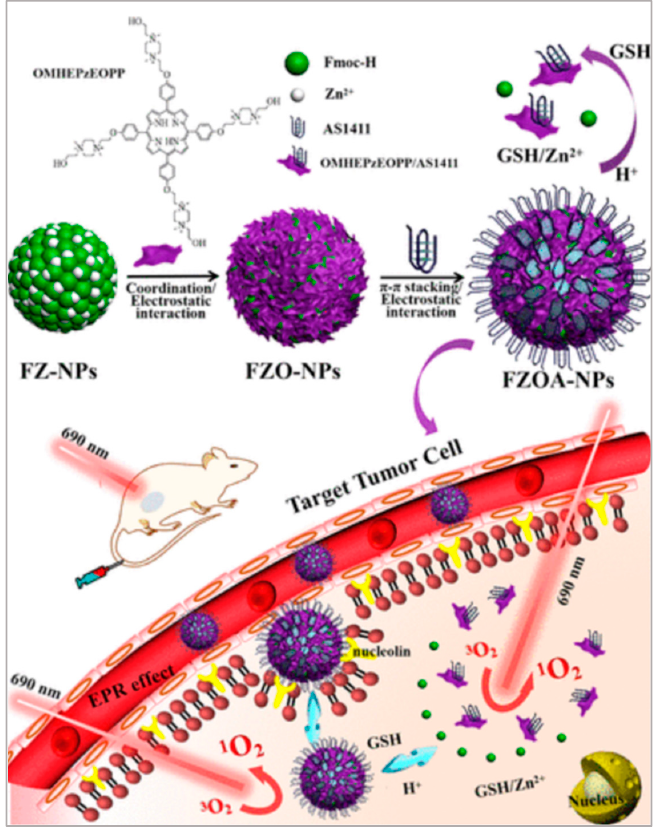
Figure 11. Preparation of FZOA-NPs and their application in tumor PDT treatment. Reprinted with permission from [119]. Copyright © 2010 American Chemical